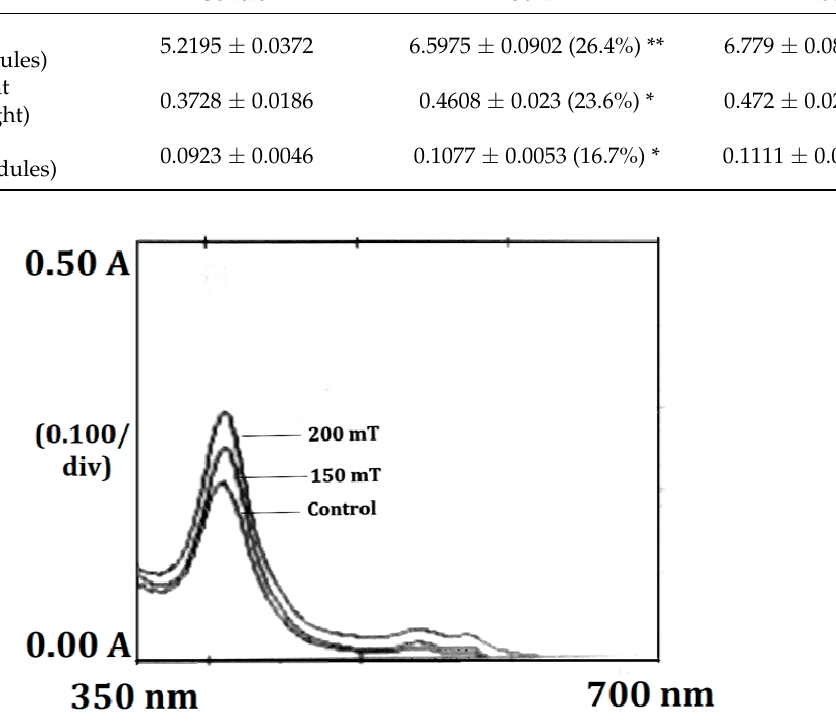
Figure 17. Spectral analysis of leghemoglobin isolated from root nodules of soybean plants on 45th DAE, where A stands for absorbance and div for divisions.